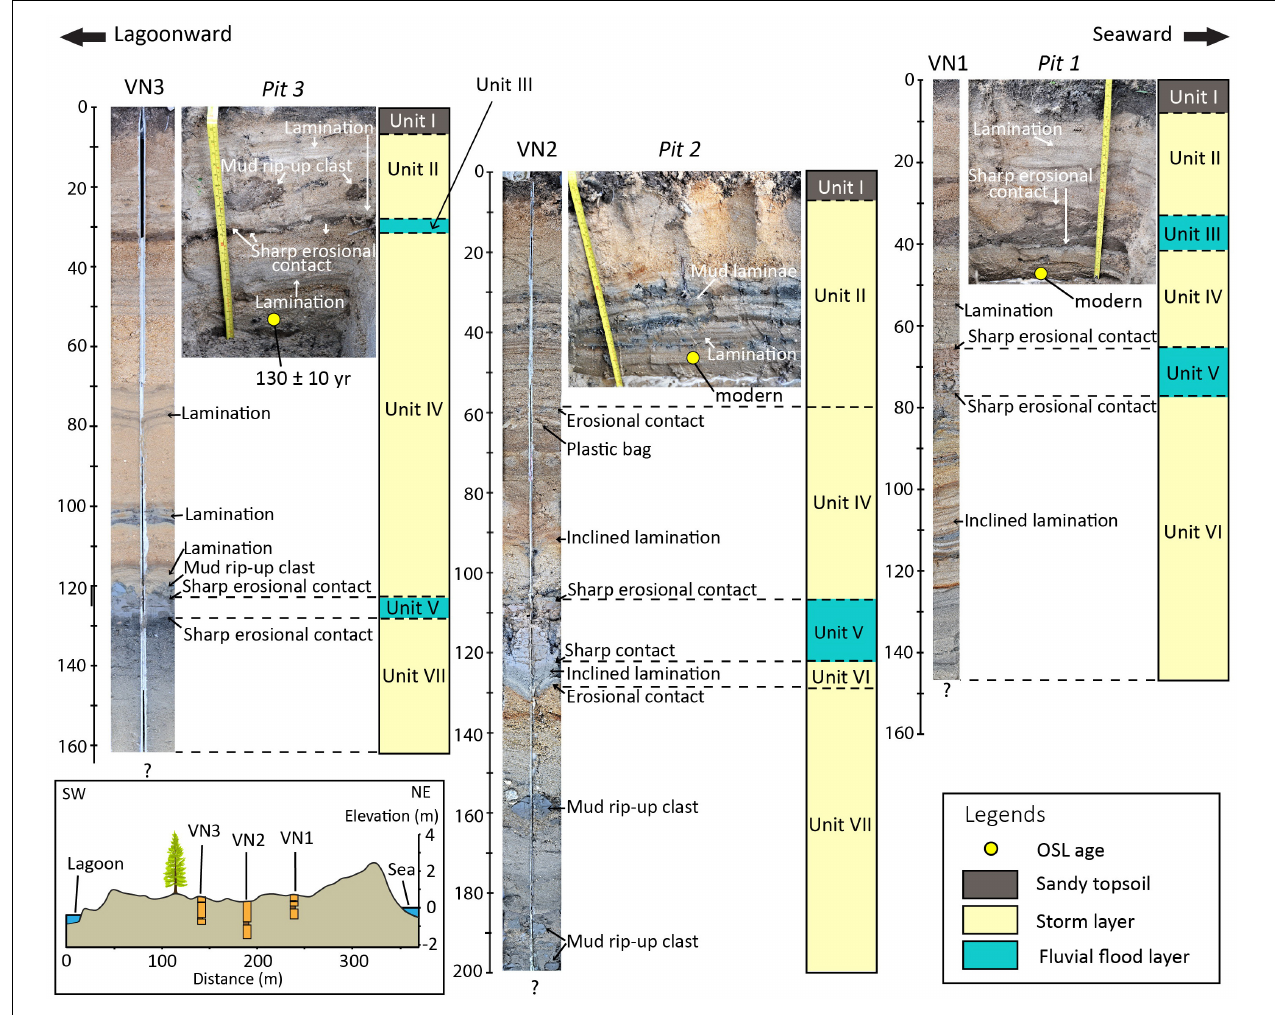
FIGURE 3 | Cores VN1, VN2, and VN3 and pits of VN1, VN2. and VN3 represent the units of deposition between the storm and FF layers with the dominant sedimentary structures. Units II, IV, VI, and VII, which were considered to be the storm layers, mostly contained sharp basal contact and inclined and parallel lamination, whereas Units III and V, classified as the FF layers, were characterized as a mud grain layer with sharp, erosional top, and bottom contacts. The absence of the FF layer (Unit III) in core VN2 and Pit VN2 resulted from the erosion of the storm event in Unit II. Note that the distance interval of each core is 50 m, and the elevation of cores is based on the topographic elevation. A yellow circle in Pit 1, Pit 2, and Pit 3 indicates the OSL ages, whereas the modern age in Pit 1 and Pit 2 means less than 100